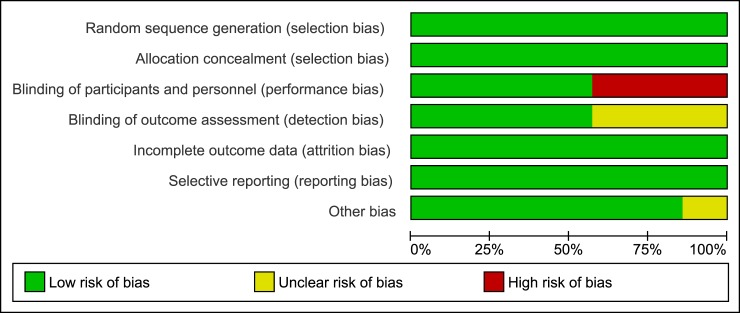
Risk of bias graph: Review authors’ judgment about each risk of bias item presented as percentage across all included studies.